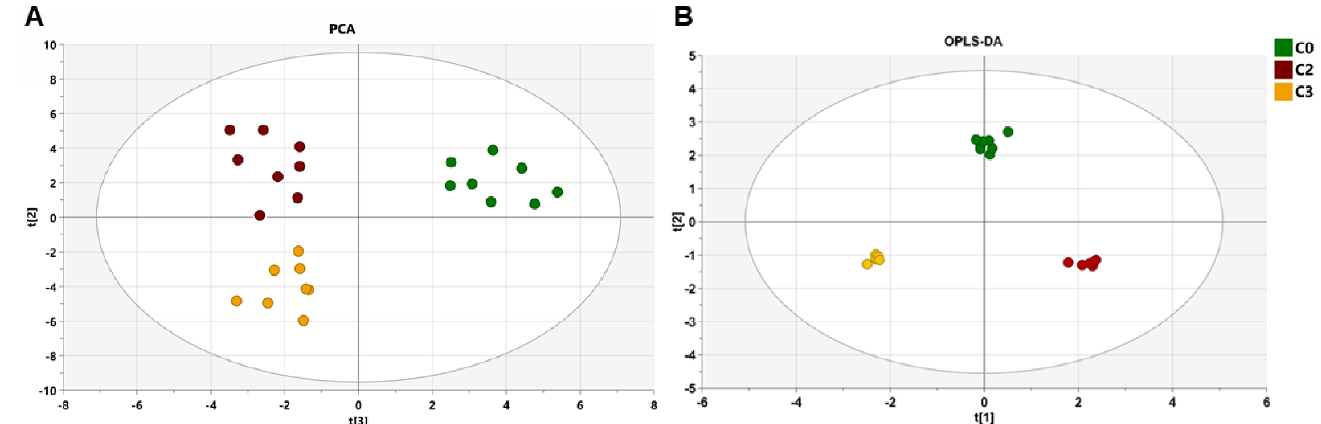
Figure 1. Principal component analysis (PCA) score plots and 2D orthogonal partial least squares discriminant analysis